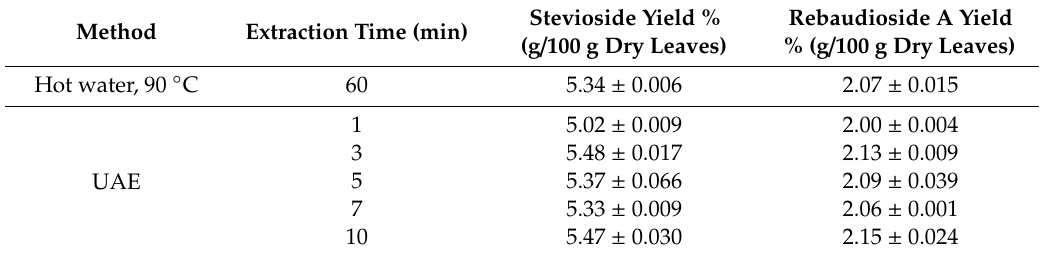
Table 6. Stevioside and rebaudioside A yield using hot water and UAE